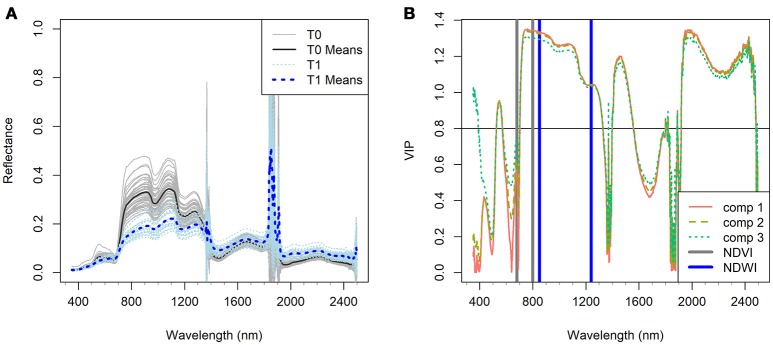
(A) Canopy hyperspectral reflectance and reflectance means of the Zymoseptoria tritici treated wheat plots (T1) in comparison with the Z. tritici untreated plots (T0) of the four reference varieties (CH CLARO, DRIFTER, RUNAL and TITLIS) at the stage of significant infection (Week 3). (B) Variable importance in projections (VIP, dimensionless) of the first three components (comp 1, 2, and 3) of PLSDA model in characterizing the difference of the two treatments (VIP ≥ 0.8 is considered as the threshold of influential contribution). Gray and blue bars indicate the spectral bands of NDVI and NDWI respectively (see formulae in Table 2).